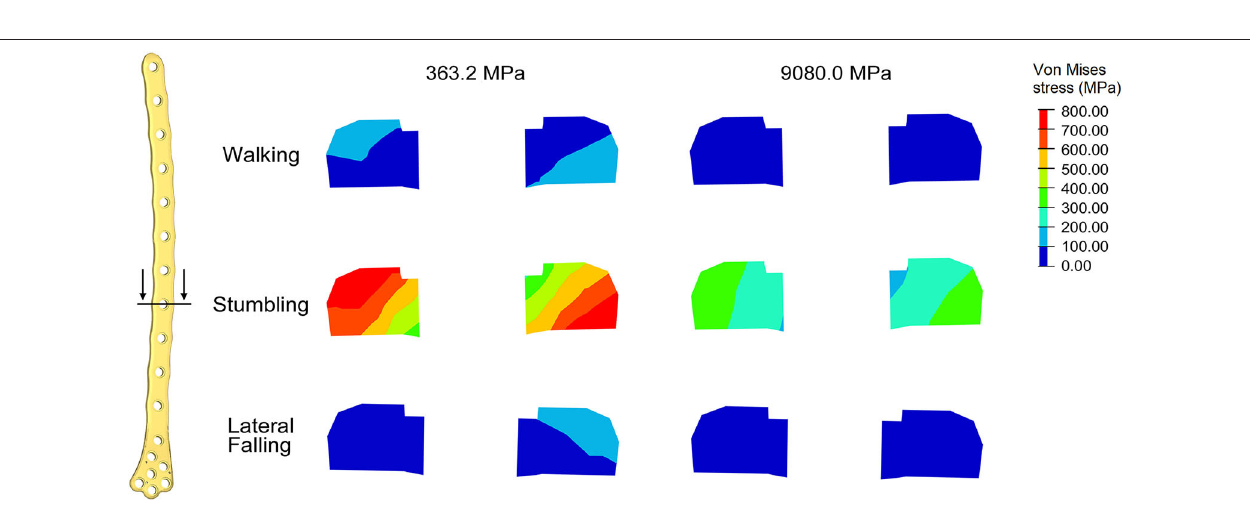
FIGURE 10 | Von Mises stresses (MPa) in the cross-section corresponding to the 11th hole, were the plate break occurred. Results for the three loading condition are shown for the models with bone callus Young’s modulus 363.2 and 9080.0 MPa.